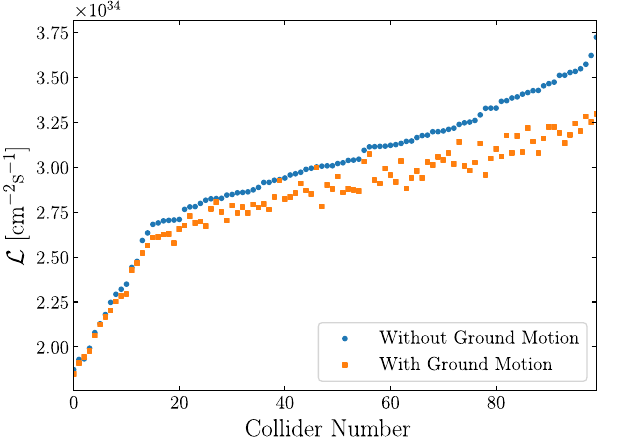
FIG. 14. Luminosity L vs collider number for 100 tuned colliders with static imperfections: with ground motion (orange square) and without ground motion (blue circle). Colliders are ordered in ascending luminosity using the colliders without ground motion.